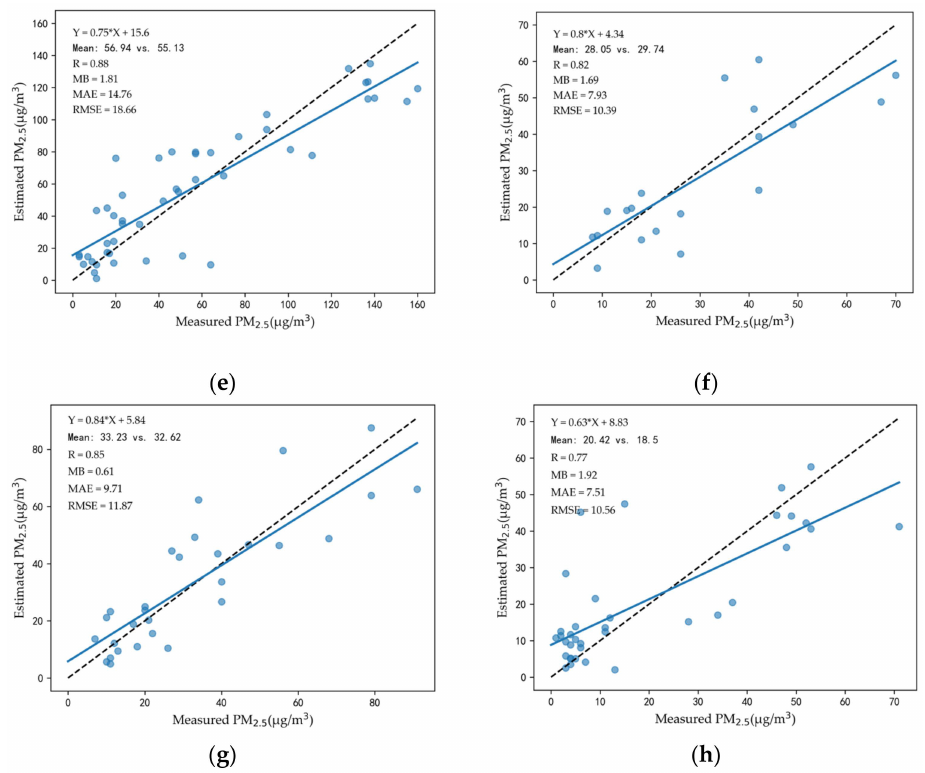
Figure 7. Scatter plots of estimated PM 2.5 and measured PM 2.5 at subsatellite points in the urban area and the suburbs: ( a – d ) is in spring, summer, autumn, and winter of the urban area, respectively; ( e – h ) is the same in the suburbs. The dashed line is the 1:1 line as a reference. Table 8. Evaluation indexes of estimated PM 2.5 and measured PM2.5 in each interval of VZA at non-substar